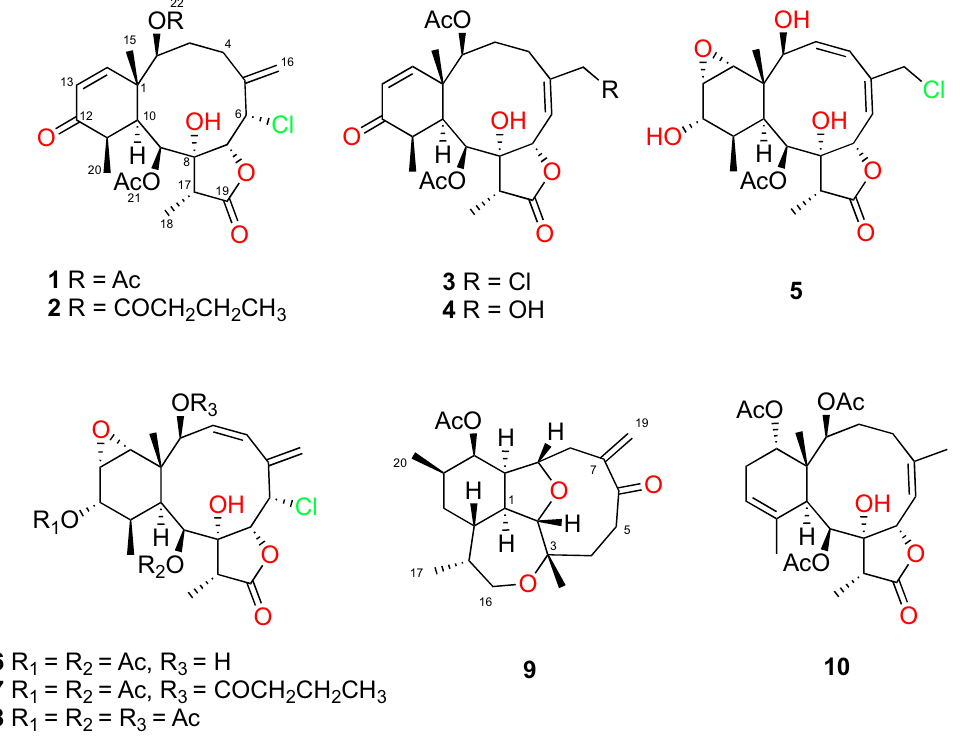
Figure 1. Briarane diterpenes isolated from Briareum asbestinum